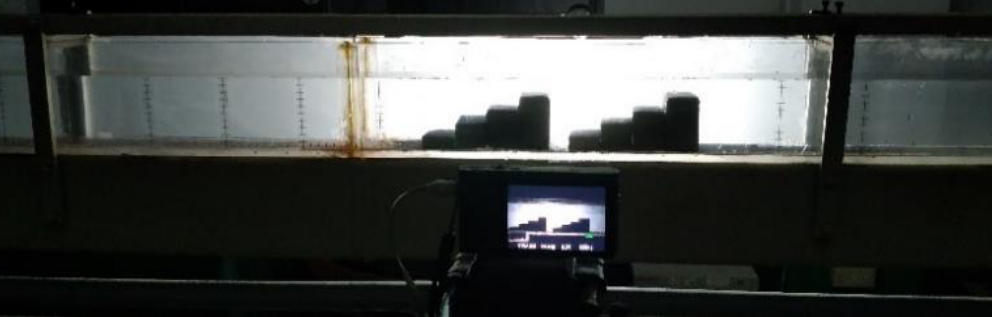
Figure 2. Experimental setup and wave vortex measurement.